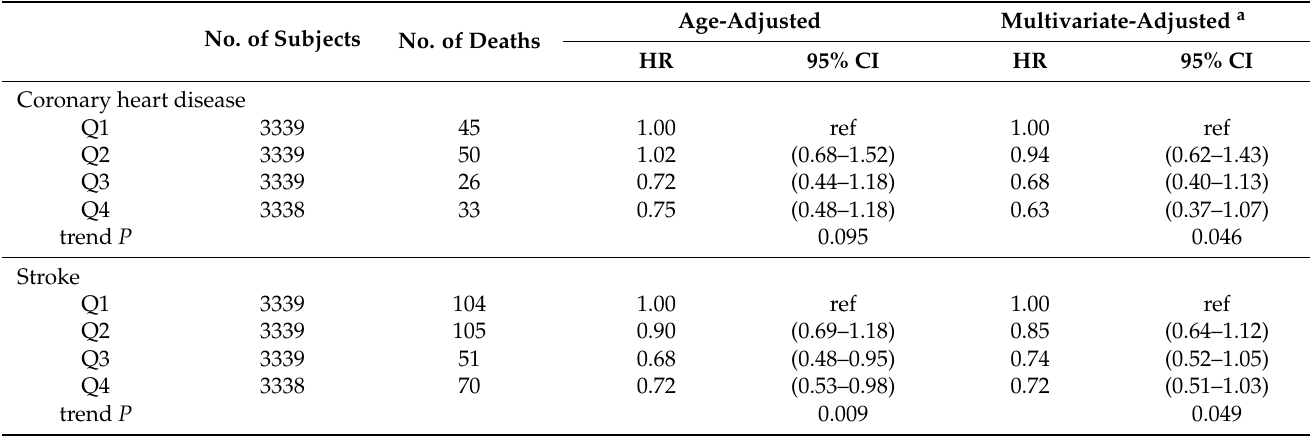
Table 5. Hazard ratios of mortality from coronary heart disease and stroke among Japanese men according to the quartiles (Q1–Q4) of intake of rice as a grain